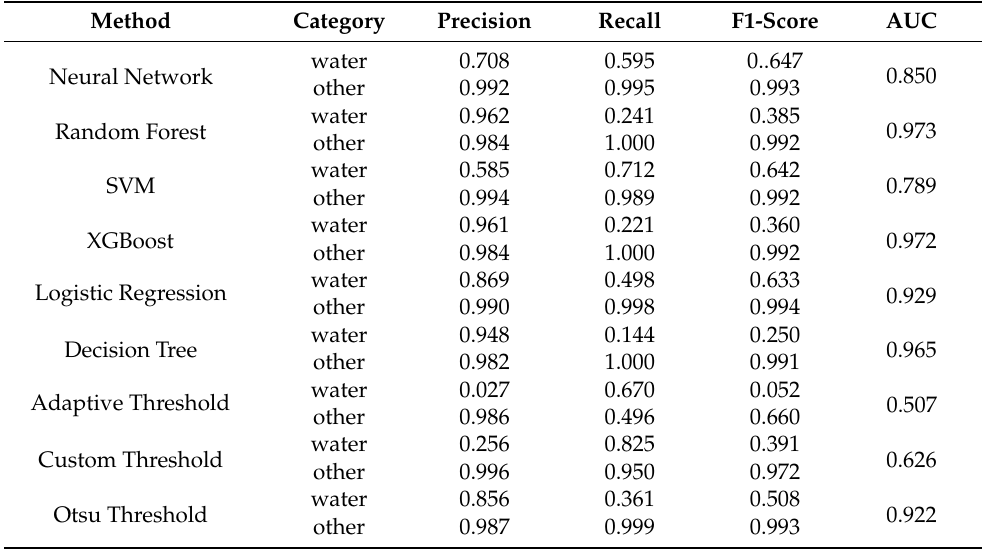
Table A3. Statistics of various indexes of each algorithm in Area2 on October 20.